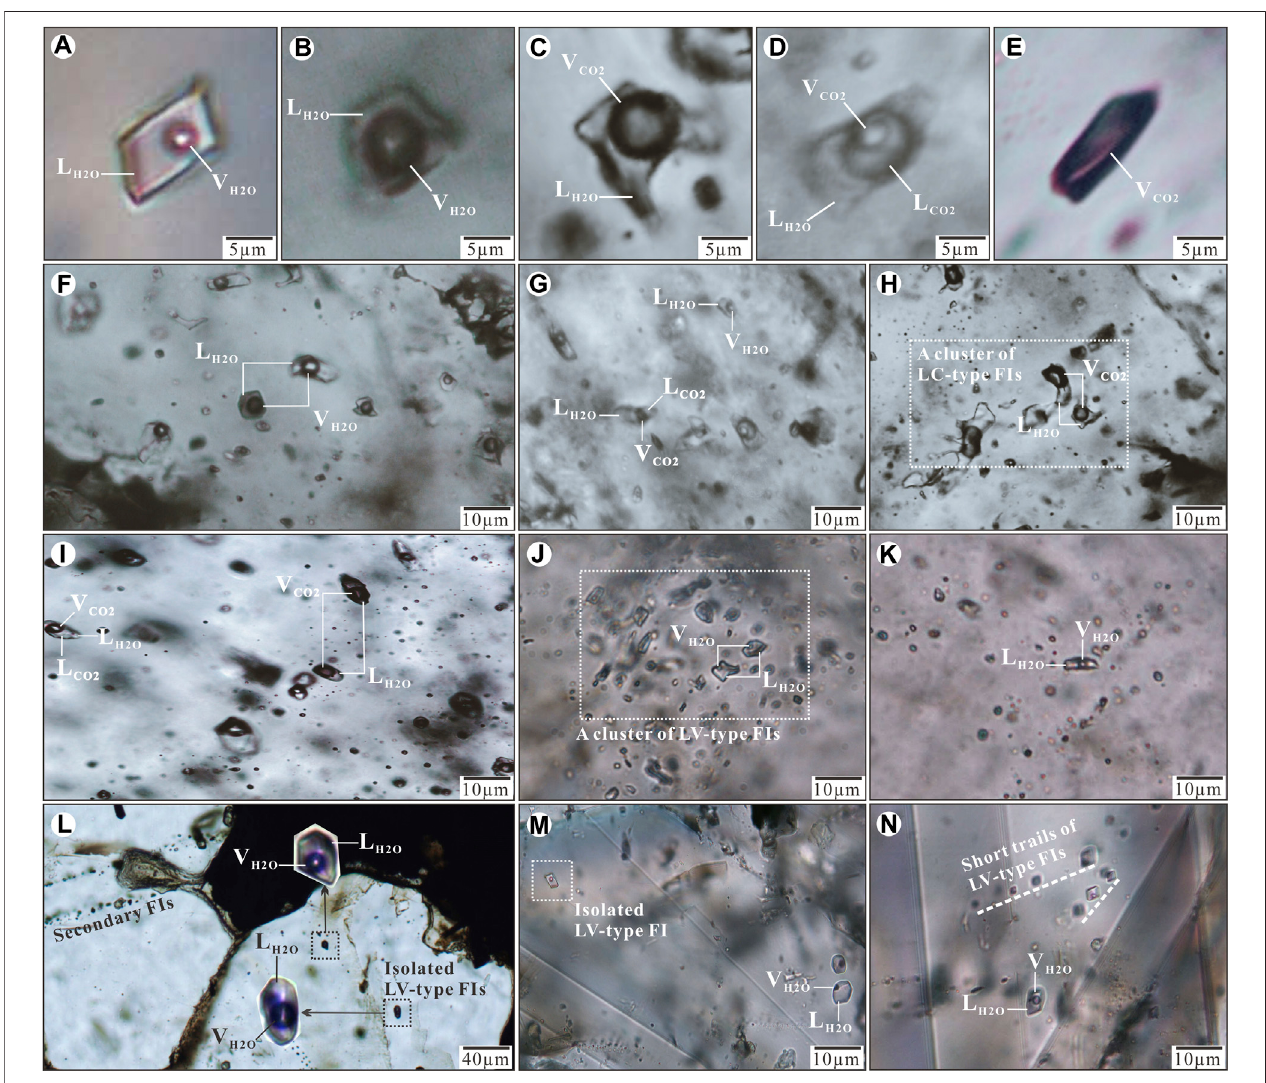
FIGURE4| PhotomicrographsofFIsinquartz andcalcite fromstages1 – 3oftheJinbagolddeposit. (A) LV – type FI; (B) VL – typeFI; (C) Twophase LC – type FI; (D) Three phase LC – type FI; (E) monophase C – type FI; (F) VL – and LV – type FIs in stage 1quartz; (G) LV – and LC – type FIs in stage 1quartz; (H) A cluster of two phase LC – type FIs in stage 1quartz; (I) Two phase and three phase LC – type FIs in stage 2 quartz; (J) A cluster of two phase LV – type FIs in stage 2 quartz; (K) LV – type FIs in stage2quartz; (L) PrimaryisolatedFIandsecondaryFIsinstage3quartz; (M) IsolatedLV – typeFIinstage3calcite; (N) ShorttrailsofLV – typeFIsinstage3calcite. Abbreviations: L H2O (liquid H 2 O), V H2O (vapor H 2 O), L CO2 (liquid CO 2 ), V CO2 (vapor CO 2